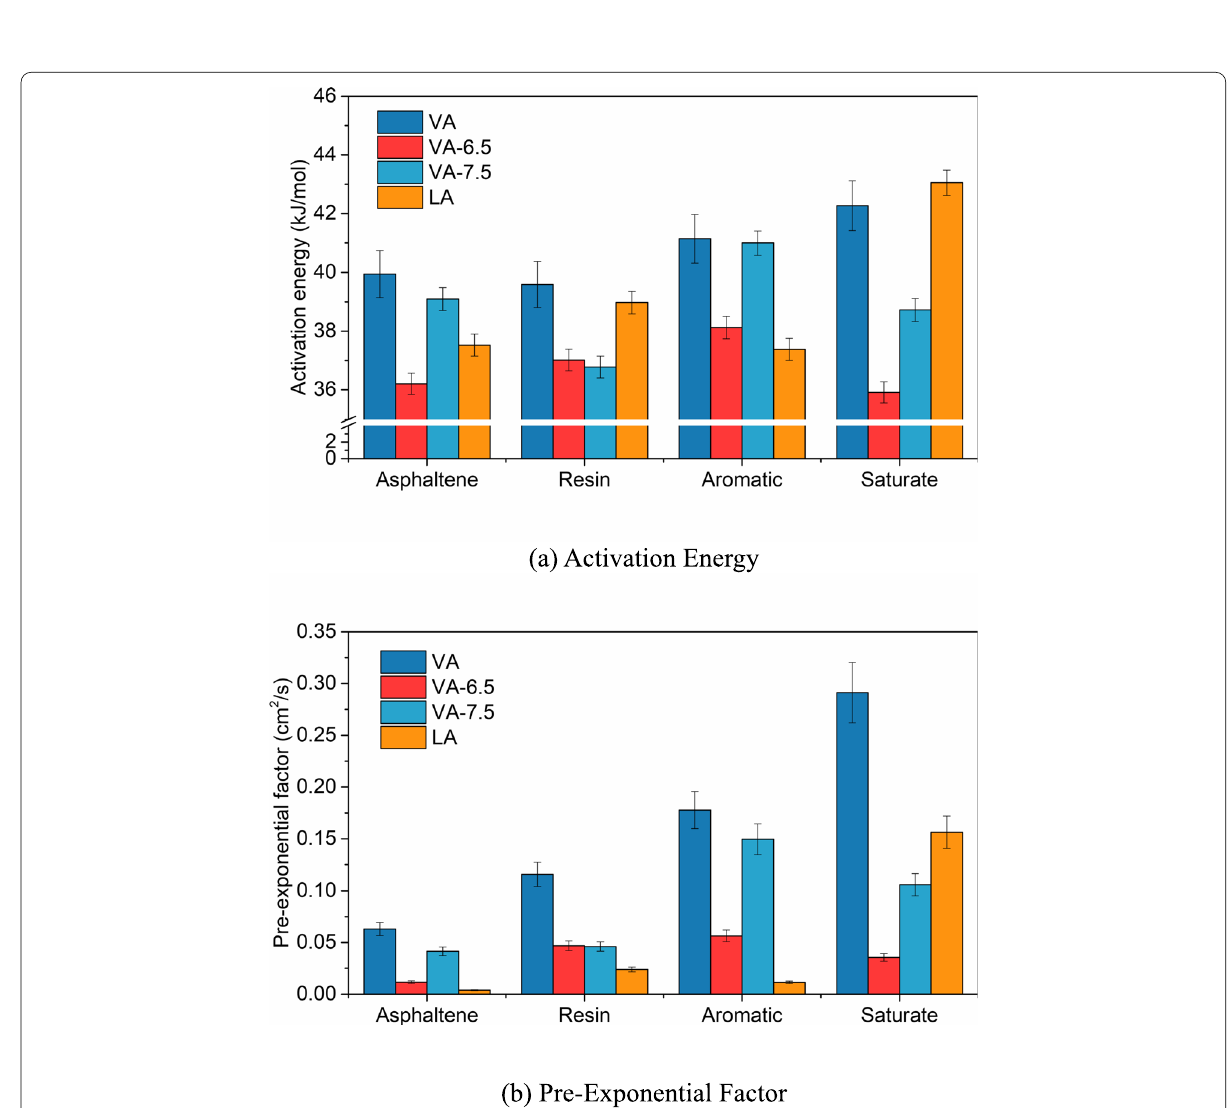
Fig. 22 Self-Healing Parameters of SARA Components in Asphalt Models: ( a ) Activation Energy, and ( b ) Pre-Exponential